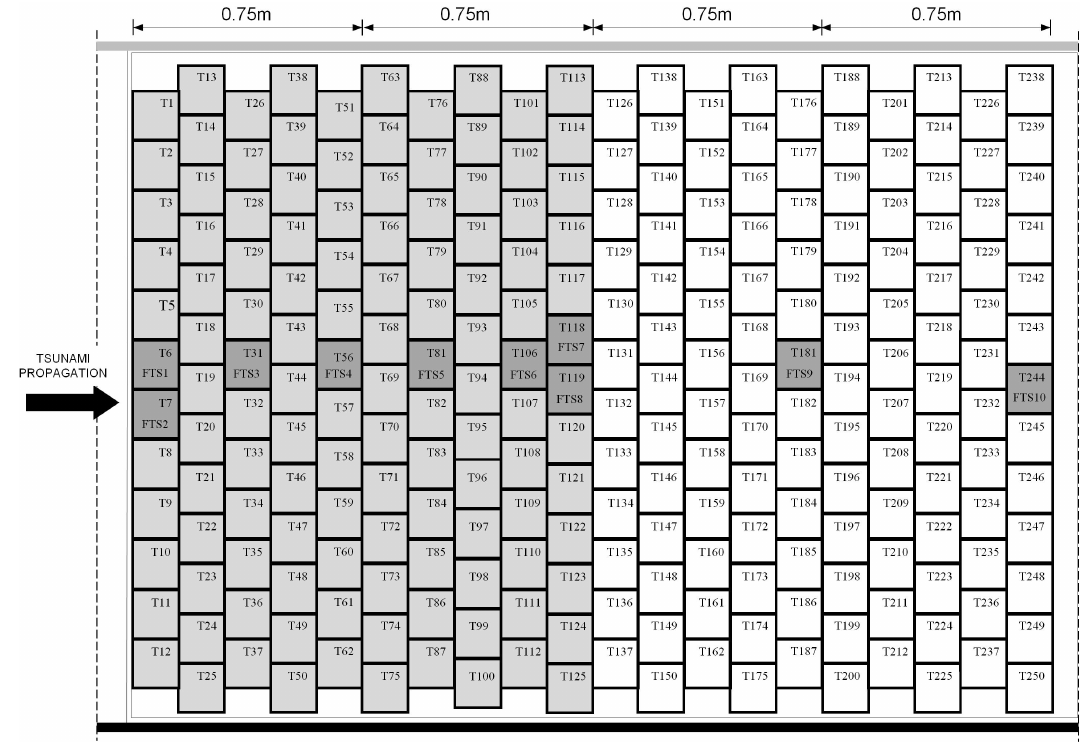
Fig. 6. Arrangement of force transducers measuring forces exerted on single tree models (FTS1–FTS10), exemplarily for tests with a bore and forest width B = 1.5m (symbols T1–T250 denote the number of the parameterized mangrove tree models, light grey colour indicates mangrove models constituting forest model of a given width, dark grey colour indicates tree models connected to force transducers